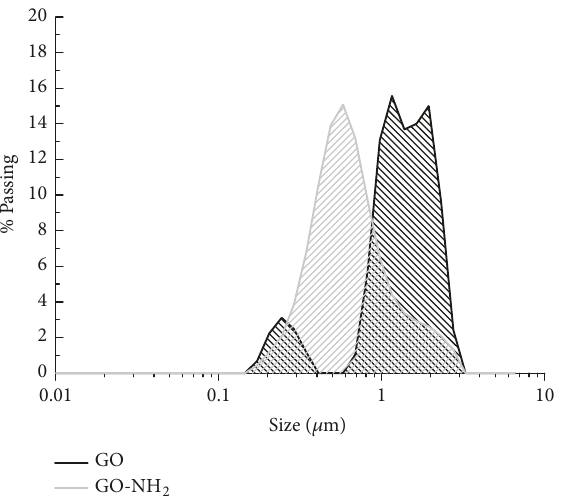
Figure 3: Pristine GO and GO-NH 2 nanoparticles size distribution.